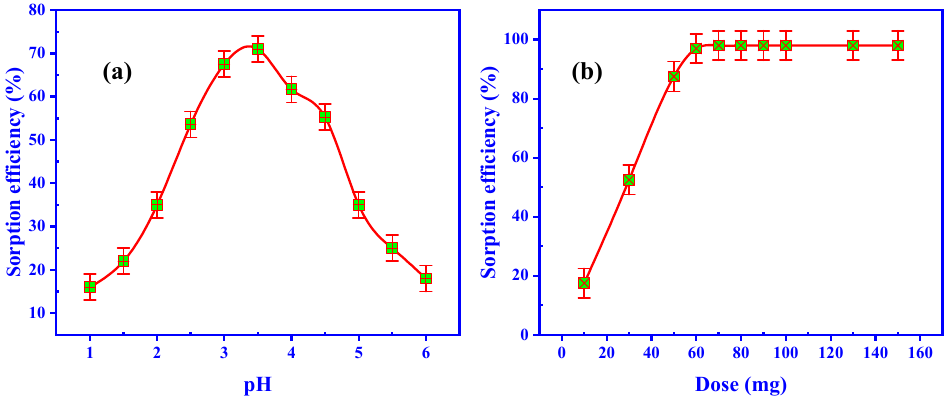
Figure 6. Influence of ( a ) pH and ( b ) ZrO 2 /CS dose on the U(VI) adsorption efficiency from leaching liquid.